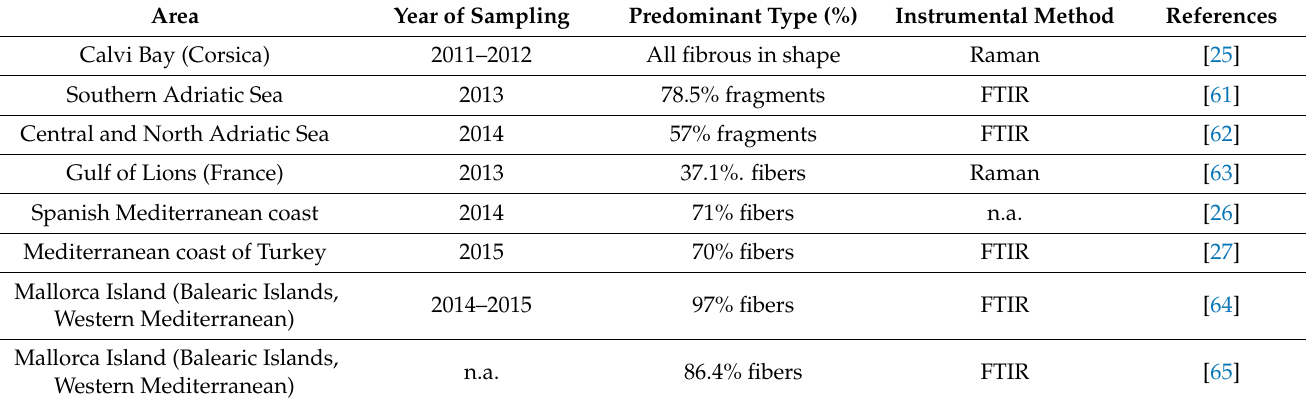
Table 1. Literature review about percentages of the predominant type of microplastic (fibers, frag- ments) in the Mediterranean Sea, region and year of sampling and instrumental method for the characterization of MPs in biota (invertebrates, fishes and sea